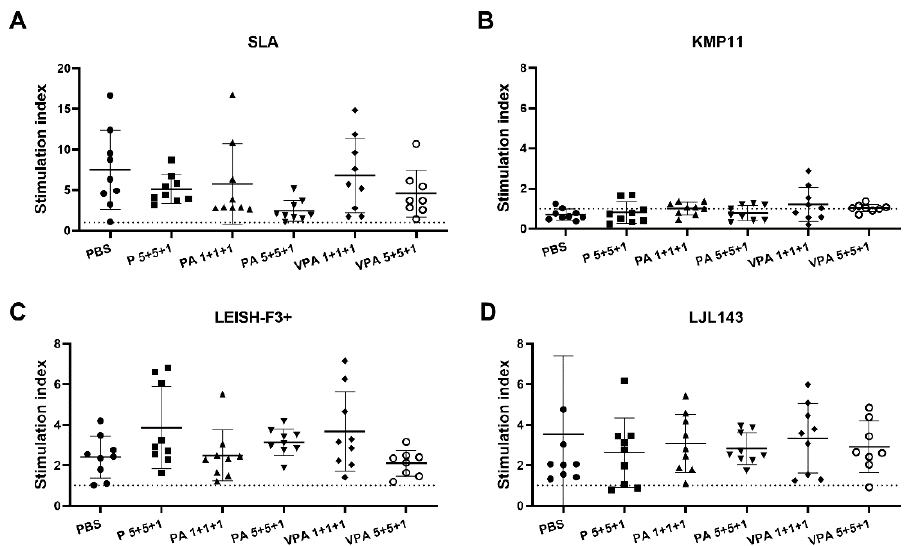
Figure 3. Antigen-specific lymphoproliferation assay in hamsters infected with L. infantum . Twelve weeks after infection, PBMCs were isolated from the peripheral blood of euthanized mice ( n = 9 hamsters per group) and stimulated with SLA ( A ), KMP11 ( B ), LEISH-F3+ ( C ) or LJL143 ( D ) (10 µg/mL each) for 5 days at 37 °C. Lymphoproliferation was determined by the measurement of BrdU incorporation by ELISA. The results show the cell stimulation index—calculated as the ratio between the absorbance of antigen-stimulated cells and the result for non-stimulated cells (RPMI control)—of each animal in a scatter plot. Dotted lines represent the stimulation index obtained in the context of three naive hamsters.